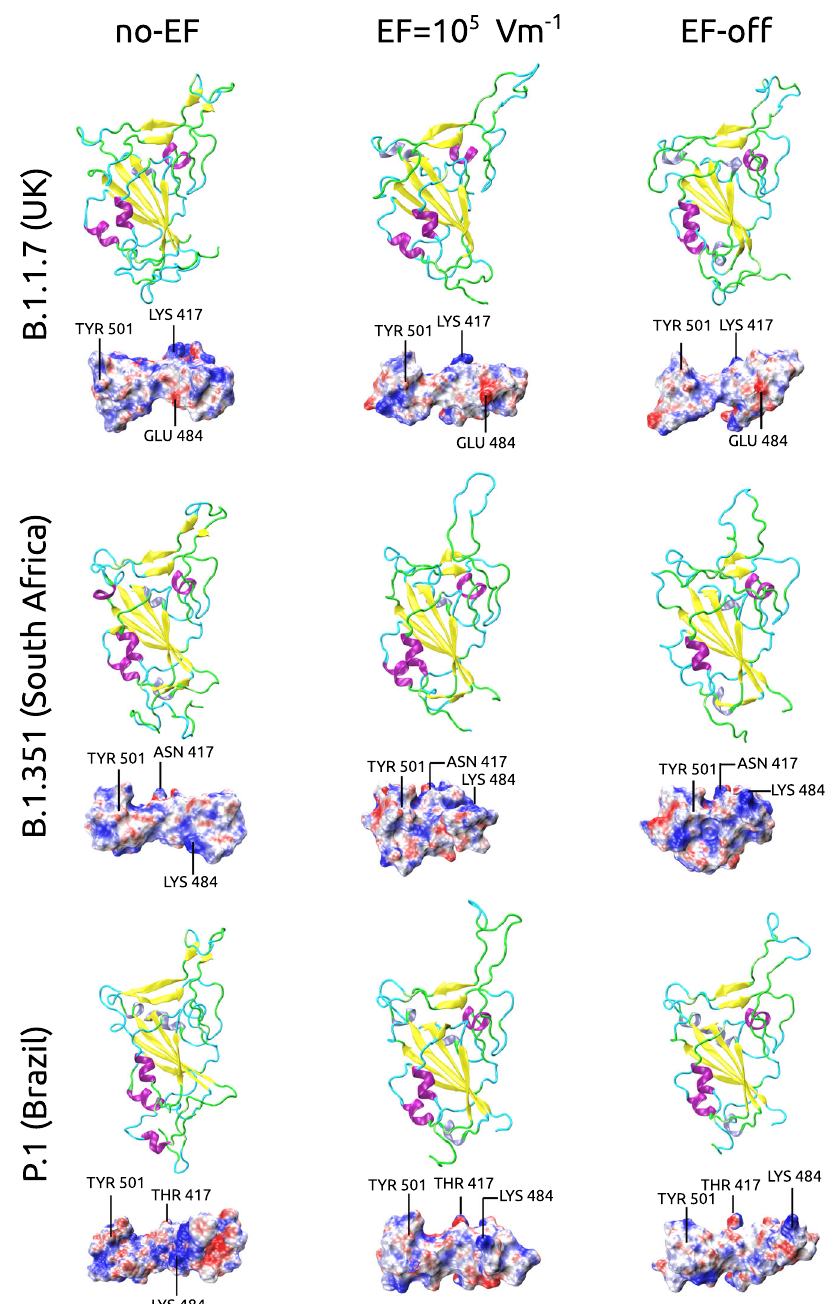
Fig. 4 Mutants of the RBD corresponding to the variants of concern B.1.1.7 (UK), B.1.351 (South Africa) and P.1 (Brazil) are also irreversibly damaged by electric fi elds. Variants were generated by replacing individual residues in silico in the 6M0J structure. The introduced mutations were N501Y (P.1, B.1.1.7 and B.1.351) K417N (B.1.351), K417T (P.1) and E484K (B.1.351 and P.1). For each of the variants, the secondary structures and the